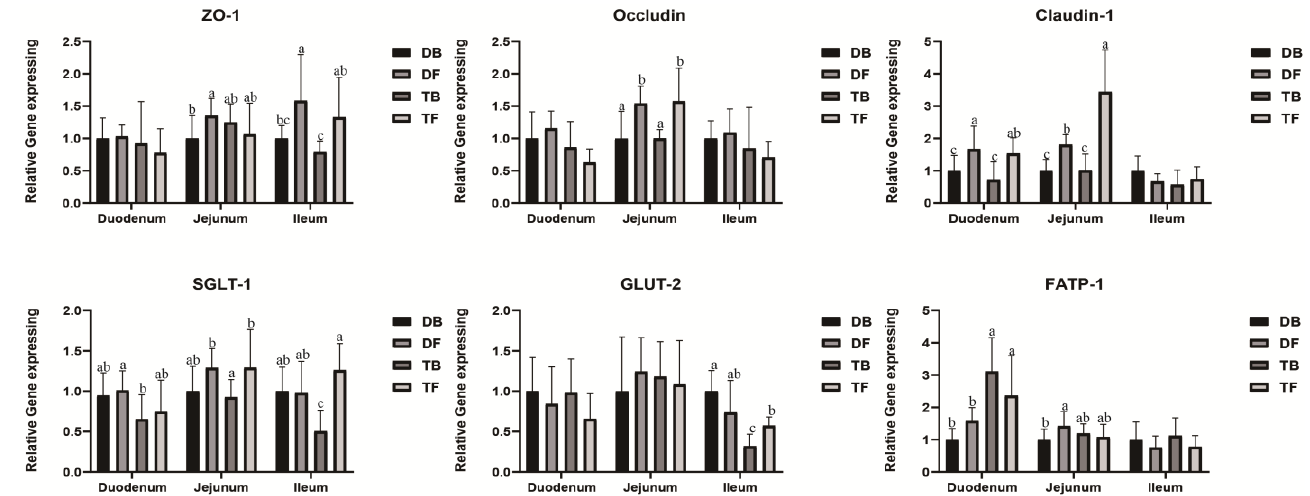
Figure 2. Effect of DF on expressions of critical genes involved in intestinal epithelium functions. ZO-1, zonula occludens-1; SGLT-1, sodium/glucose cotransporter-1; GLUT-2, glucose transporter-2; FATP, fatty acid transport protein-1; a , b , c , mean values within a row with different superscript letters were significantly different ( p < 0.05). DB, Durocs were exposed to a basal diet; DF, Durocs were exposed to a high-fiber diet; TB, Taoyuan pigs were exposed to a basal diet; TF, Taoyuan pigs were exposed to a high-fiber